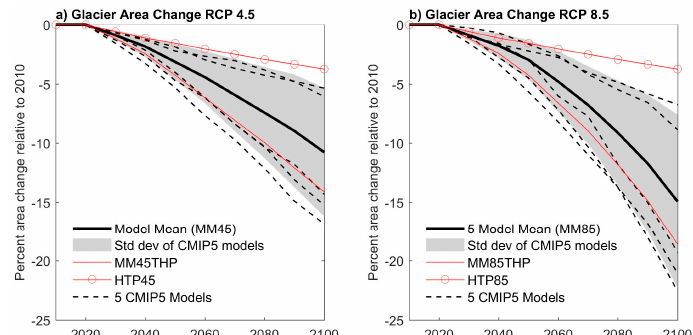
Figure 5. Projected changes in glacierized area based on 8 climate scenarios for: ( a ) RCP 4.5; and ( b ) RCP 8.5. The five dashed lines represent results from all CMIP5 models, and the solid black line is based on simulations using climate forcing data from the five-model mean. The red lines with circles represent HTP45 and HTP85 simulations. The red solid lines represent MM45THP and MM85THP simulations. The difference between the two red lines reflects the impact of temperature rise alone. The difference between the solid red line and the solid black line shows the mitigating effect of high winter precipitation on glacier loss. Gray shading illustrates the standard deviation of the five CMIP5 models.